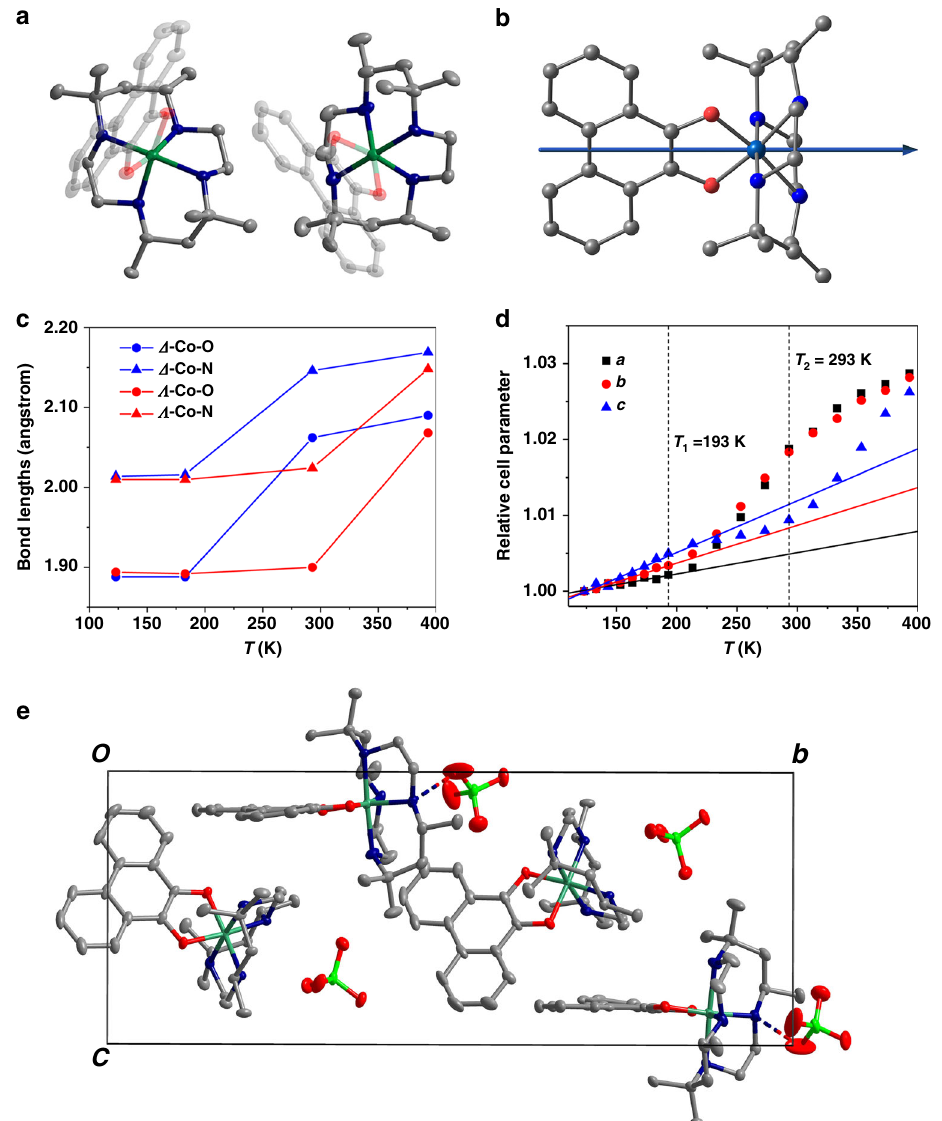
Fig. 3 Crystal structures and packing modes of 1·0.5EtOH. a Crystal structure of the pair of Δ -[Co(phendiox)(cth)] (left) and Λ -[Co(phendiox)(cth)] (right) in 1 ·0.5EtOH at 123 K. Hydrogen atoms, anions, and solvent molecules are omitted for clarity; b calculated direction of the molecular dipole moment; c temperature-dependent bond lengths around Co centers; d temperature-dependent cell parameters normalized with respect to their values at 123 K. Solid lines represent the linear fi tting of the thermal expansion parameters; e crystal packing viewed along the a -axis. The b -axis is the polar axis. Cobalt is shown in malachite, oxygen in red, carbon in gray, nitrogen in navy, and chlorine in green. Hydrogen atoms and solvent molecules are omitted for clarity. Hydrogen bonds between perchlorate groups and the Λ -Co motifs are represented by dashed (Supplementary Fig. 4). The asymmetric unit is composed of an enantiomeric pair of cobalt motifs ( Λ -[Co(phendiox)( RR -cth)] + and Δ -[Co(phendiox)( SS -cth)] + ), two perchlorate anions, and one ethanol molecule (Fig. 3a and Supplementary Fig. 5). The Co ion is 6-coordinated by four N atoms from the cth ligand and two O atoms from the phendiox ligand. At 123 K, the Co – O and Co – N bond lengths range from 1.887(2) to 1.897(3) Å and from 1.997(3) to 2.031(3) Å, respectively, while the C – O bond lengths range from 1.348(4) to 1.358(4) Å. These bond lengths are typical of catecholato-form phendiox ligand ((phenCat) 2 − ) and the low- spin (LS) Co(III) ion. At 293 K, the coordination bond around the Δ -Co motif exhibits a signi fi cant elongation with Co – O and Co – N bond lengths ranging from 2.058(3) to 2.065(3) Å and from 2.127(3) to 2.175(3) Å, respectively. The C – O bond lengths shrink correspondingly to 1.289(5) and 1.297(5) Å. Such changes